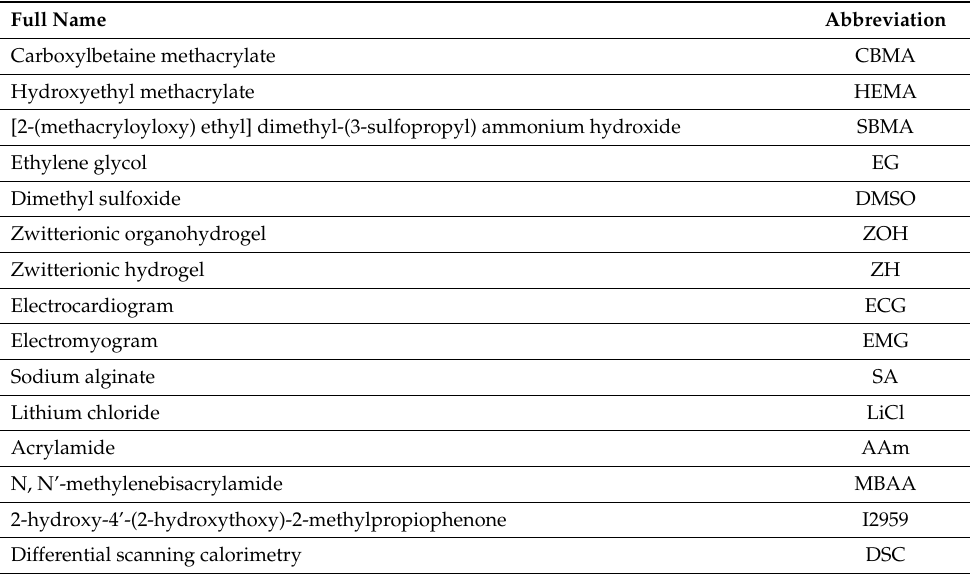
Table 1. Full names and abbreviations of materials and tests in the